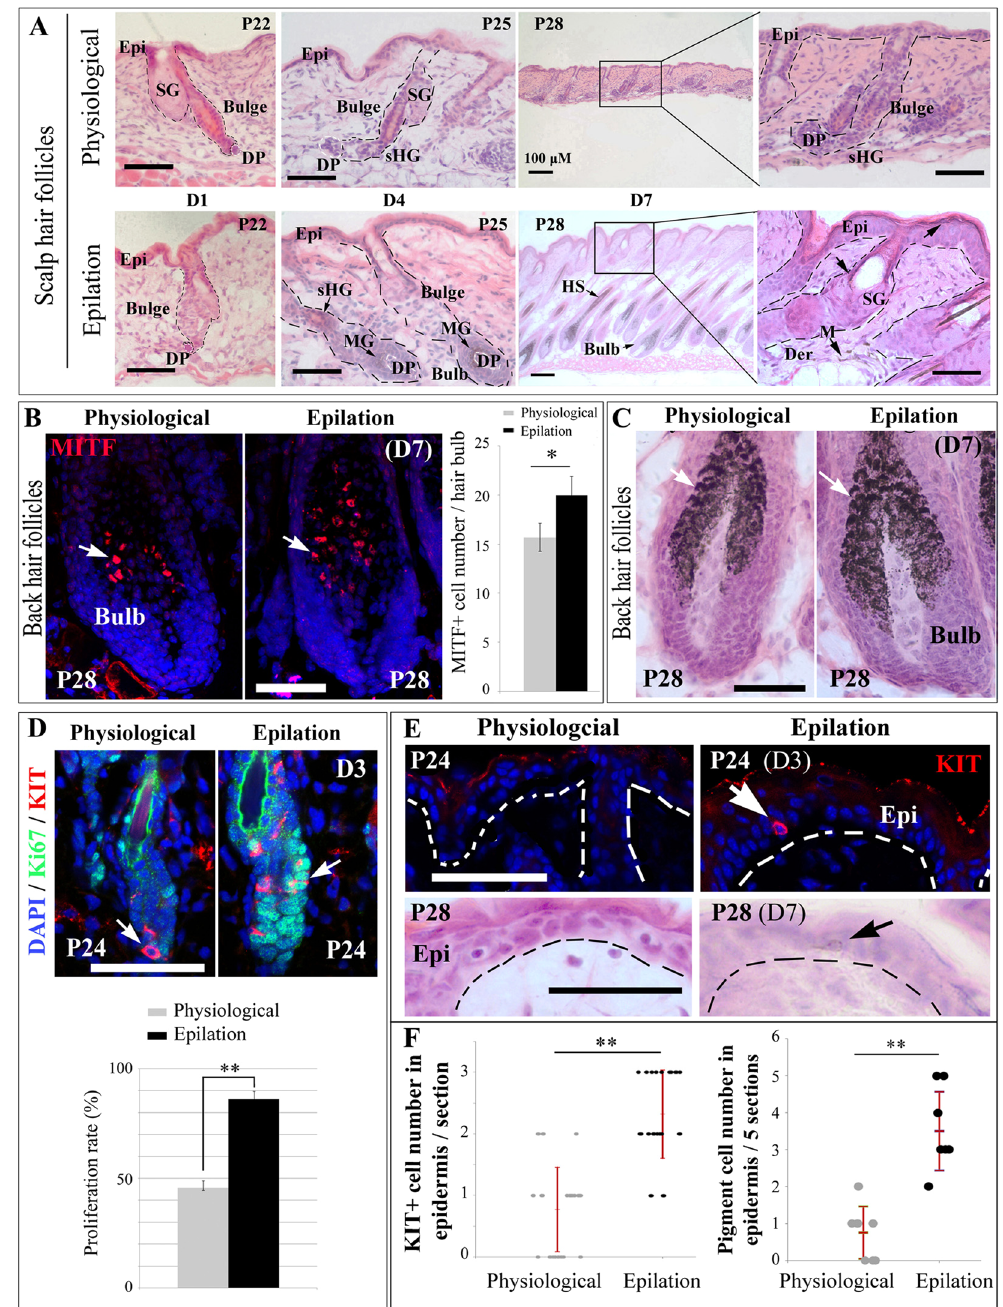
Figure 2. Epilation stimulates McSC proliferation, leads to regeneration of epidermal melanocytes and induces expression of melanogenesis-related genes. ( A ) H&E staining of distinct stages of scalp hair cycling 1, 4, and 7 days after epilation. C57BL/6 mice were epilated at P21 and the histology of hair follicles was analyzed at the indicated days. ( B , C ) Anti-MITF immunostaining ( B ) and H&E staining ( C ) of back hair follicles from control mice at P28 and age-matched mice epilated at P21. Arrows indicate the MITF + cells ( B ) and melanin granules in the hair bulb ( C ). The 3D images of anti-MITF immunostaining are shown in Fig. S10. ( D ) Immunostaining of anti-KIT and Ki67 in back hair follicles of C57BL/6J mice 3 days after epilation. Note that epilation induces proliferation of McSCs. Arrows indicate the KIT + cells in the hair bulge. ( E ) Anti-KIT immunostaining of back skin from control mice at P24 and age-matched mice epilated at P21 (upper panels) and H&E staining of back skin (lower panels) on day 7 after epilation. Note KIT-positive cells in the epidermis 3 days after epilation and pigmented melanocytes in the epidermis 7 days after epilation. Arrows indicate the KIT + cell (upper panels) and pigmented cell (lower panels). ( F ) graphs show the number of Kit + (left panel) and pigmented cells (right panel) in the epidermis 3 days and 7 days after epilation, respectively. DP, dermal papilla; Epi, epidermis; Der, dermis; M, melanocyte; MG, melanin granules; SG, sebaceous gland; sHG, secondary hair germ. Bar, 50 μ m. * Indicates p < 0.05, ** indicates p <